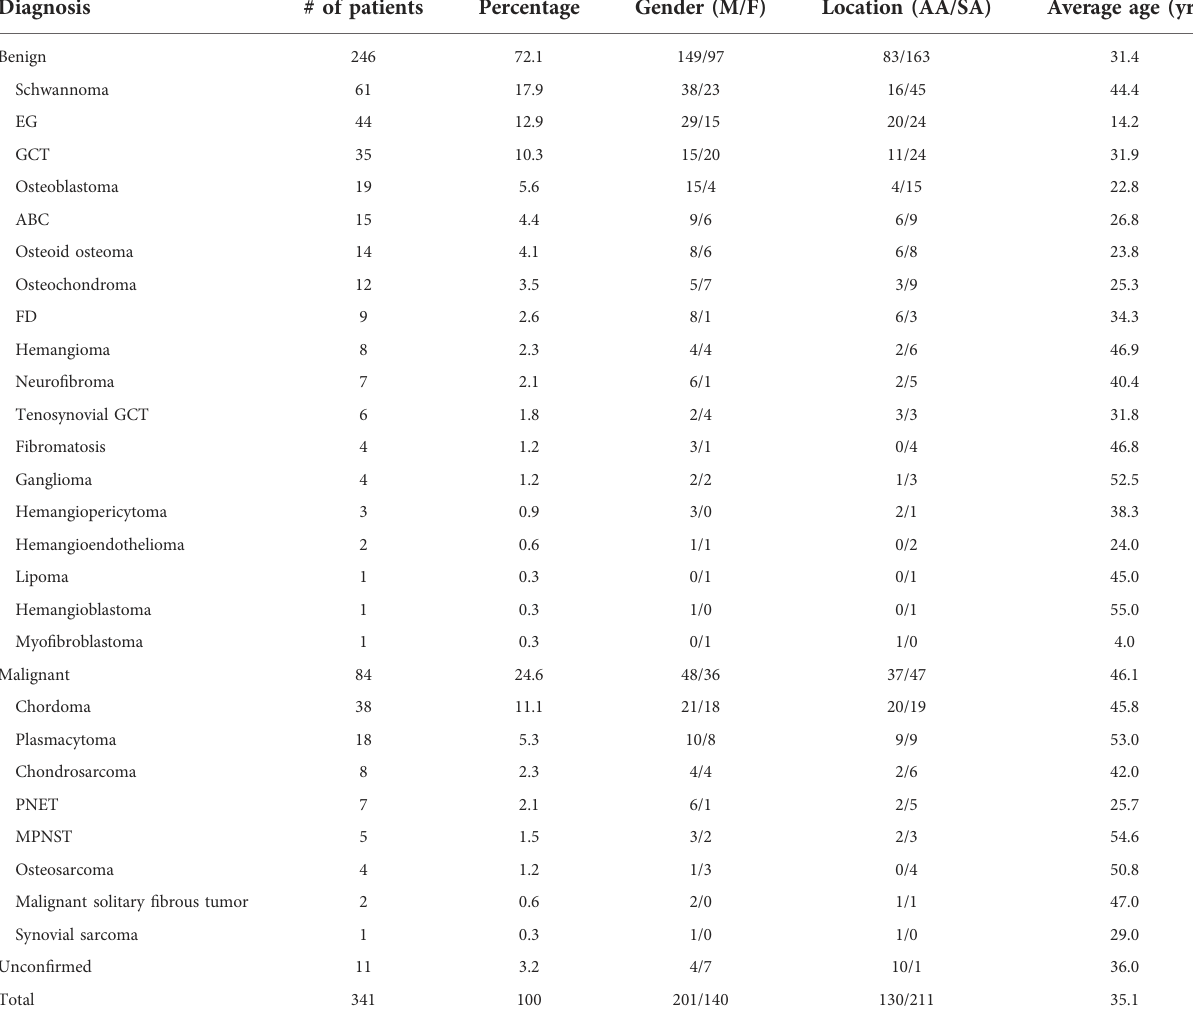
TABLE 1 Numbers and proportions of cases corresponding to different tumor types. Diagnosis # of